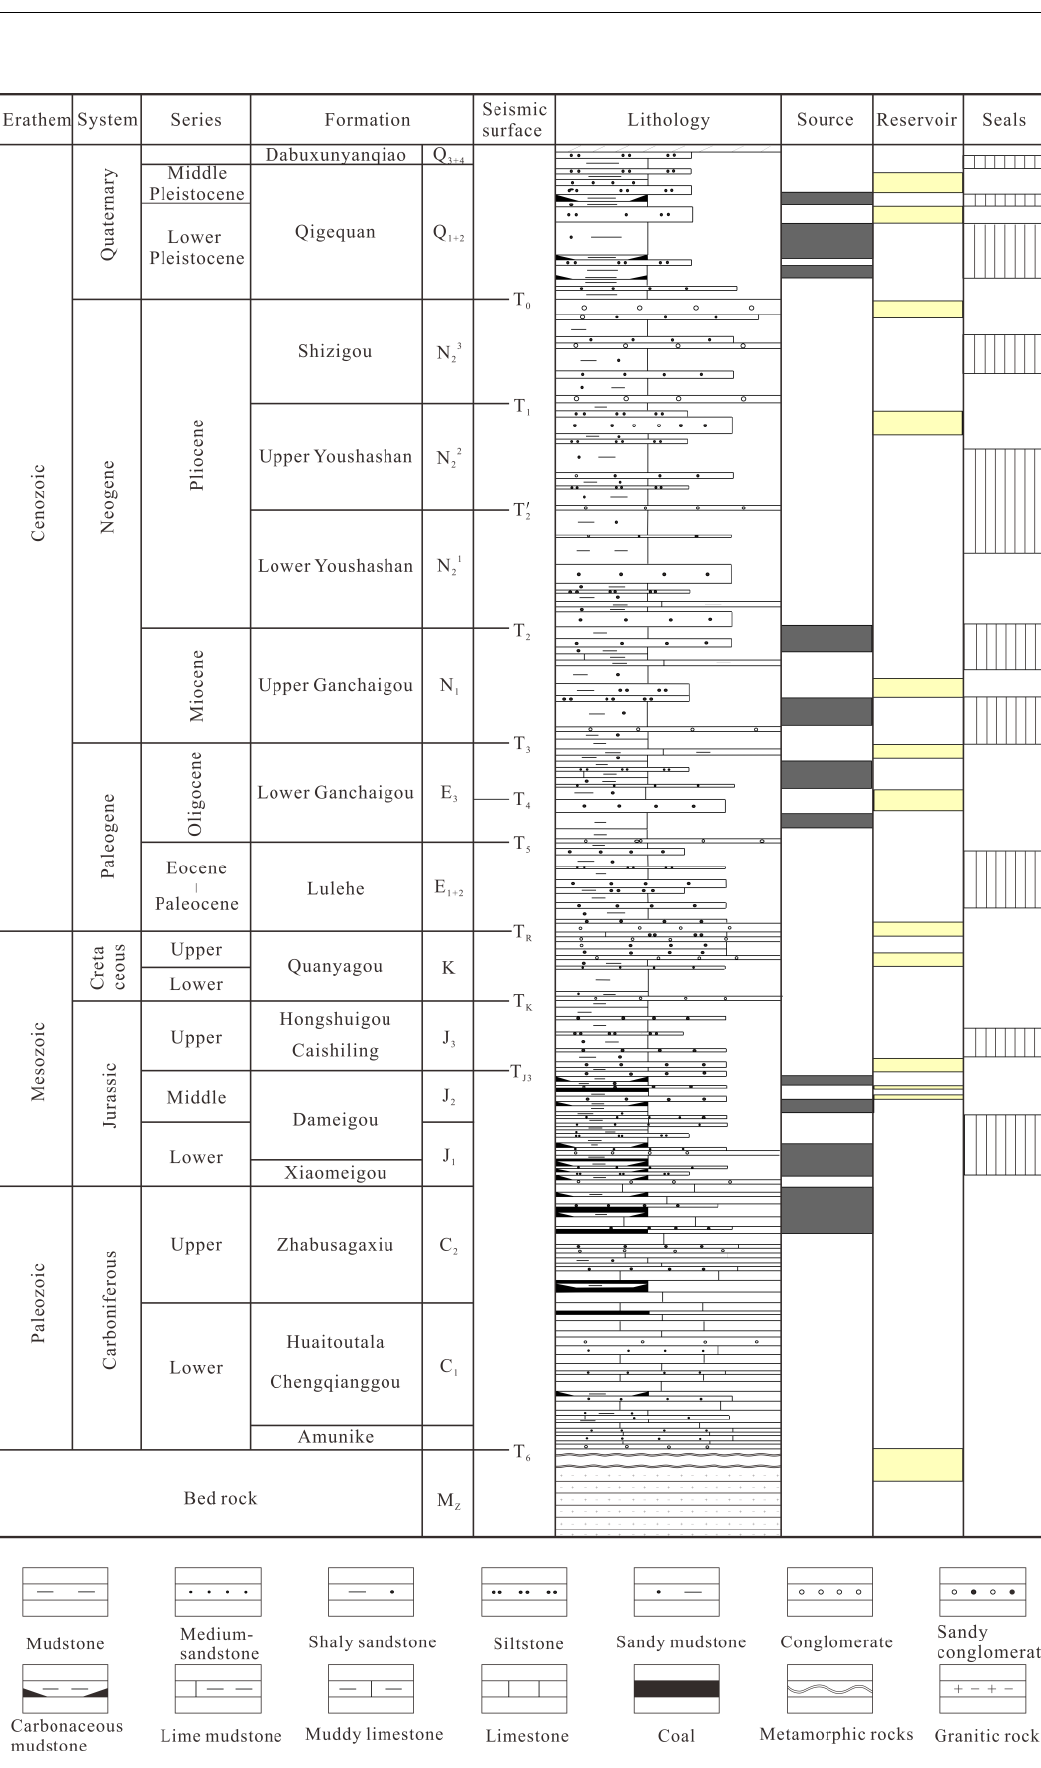
Figure 2. Stratigraphy column of the Qaidam